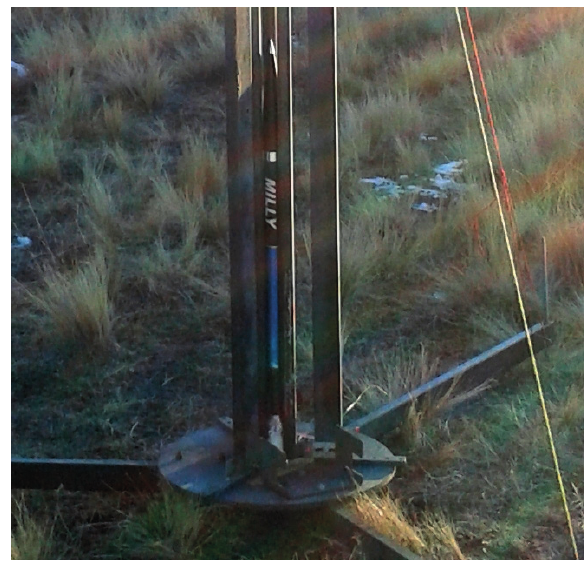
Figure 12. Milly inside launch